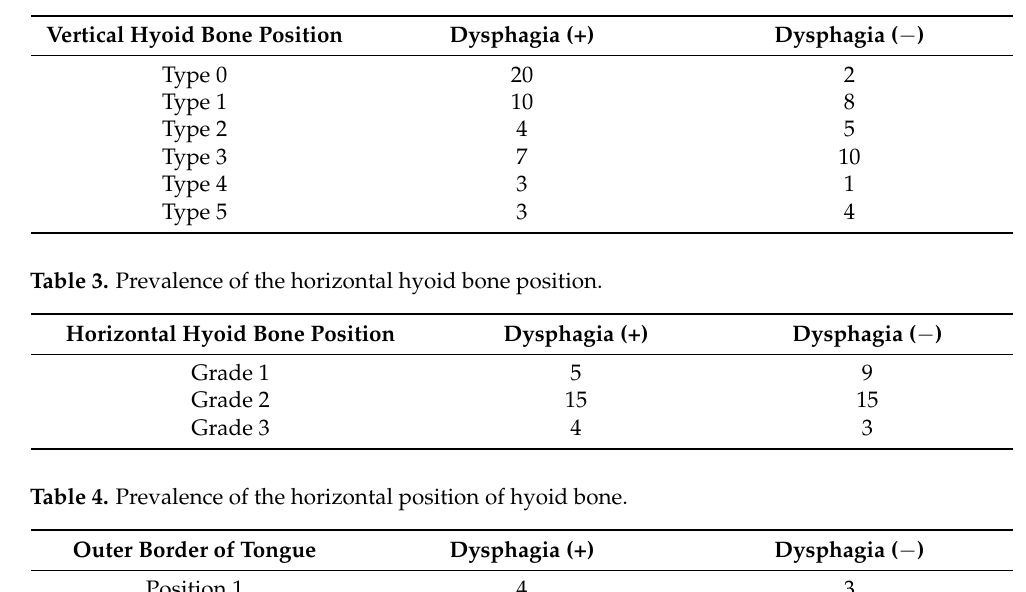
Table 2. Prevalence of the vertical hyoid bone position.